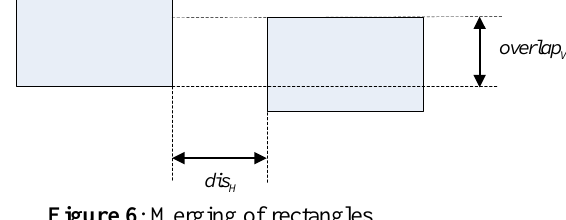
Figure 6 : Merging of